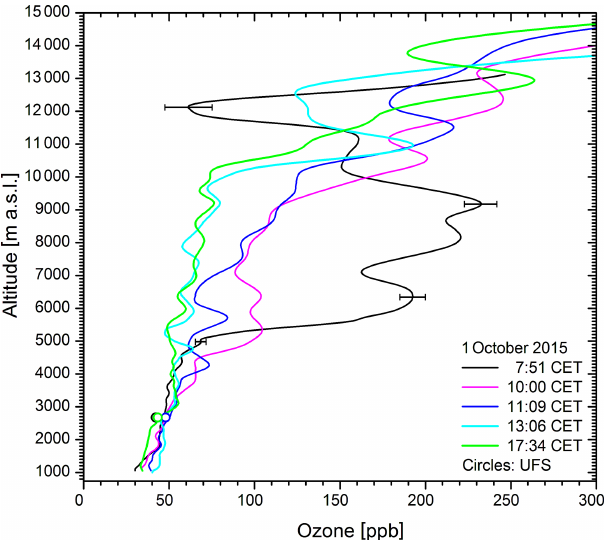
Figure 2. Vertical ozone profiles from the lidar measurements on 1 October 2015; 235ppb is the highest mixing ratio ever measured with the IFU DIAL since the beginning of the mea- surements in 1991. The distribution changes dramatically within about 10h. The Munich thermal tropopause level was 10454m (00:00UTC = 01:00CET) and 11903m (12:00UTC). The min- imum sonde RH was 2% (00:00UTC) and 1% (cut-off level, 12:00UTC). The in situ data (1h averages) of UFS (2670m) are marked with circles coded in the same colours as the lidar measure- ments next to the same time. A few error estimates representative of the respective altitudes are given for a judgement of the data